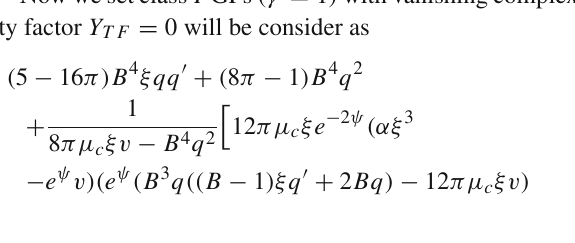
Fig. 6 Curves of